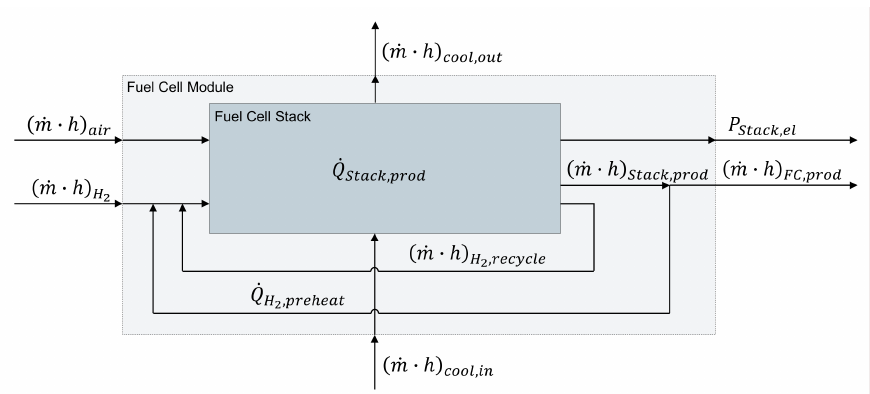
Figure 4. Schematic representation of FC stack including surrounding auxiliary control volume for thermal balance